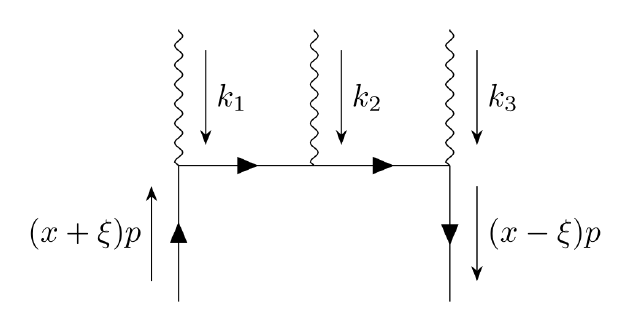
Figure 1: The general form of the LO diagram. As described in the text, to simplify computations we first consider a diagram with 3 incoming photons, and use after- wards the appropriate